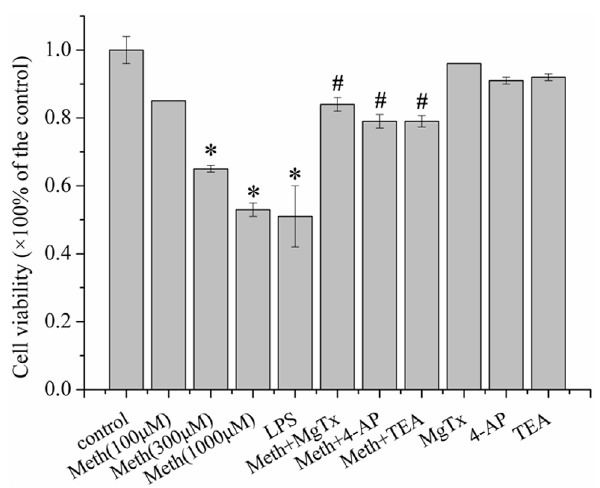
Figure 2. Kv1.3 channel involved in Meth mediated microglial damage. The cells were pre-incubated with 4-AP (1 mM), TEA (5 mM) and MgTx (10 nM) for 30 min before addition of Meth (300 m M). After the treatment of Meth for 24 h, the cell viability was evaluated by the CCK-8 assay. The toxic effect of Meth was dose-dependent, with a significant reduction at 300 and 1000 m M. The injury was partly retarded by the Kv antagonist 4-AP, TEA and MgTx. LPS (1000 ng/ml) was used for the positive control. Absorbance was measured at a wavelength of 450 nm using a microplate reader. Each data point represents mean 6 S.E. of at least three separate experiments in which treatments were performed in quadruplicates. * indicates significant difference when the values were compared to that of the control. (*p , 0.05) and # indicates significant difference when the values were compared to that in the Meth treated group (300 m